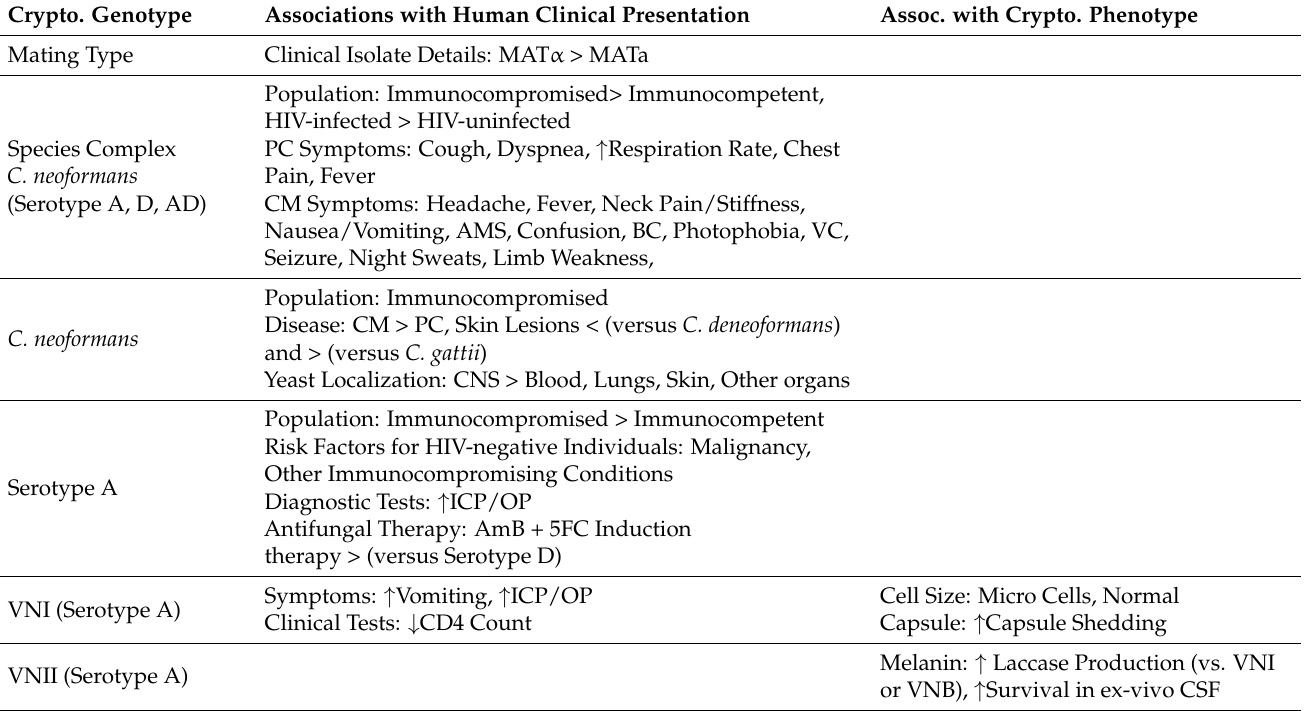
Table 2. Cryptococcal Genotype Associations with Cryptococcal Phenotypes and Human Clinical Presentation. Crypto. Genotype Associations with Human Clinical Presentation Assoc. with Crypto.